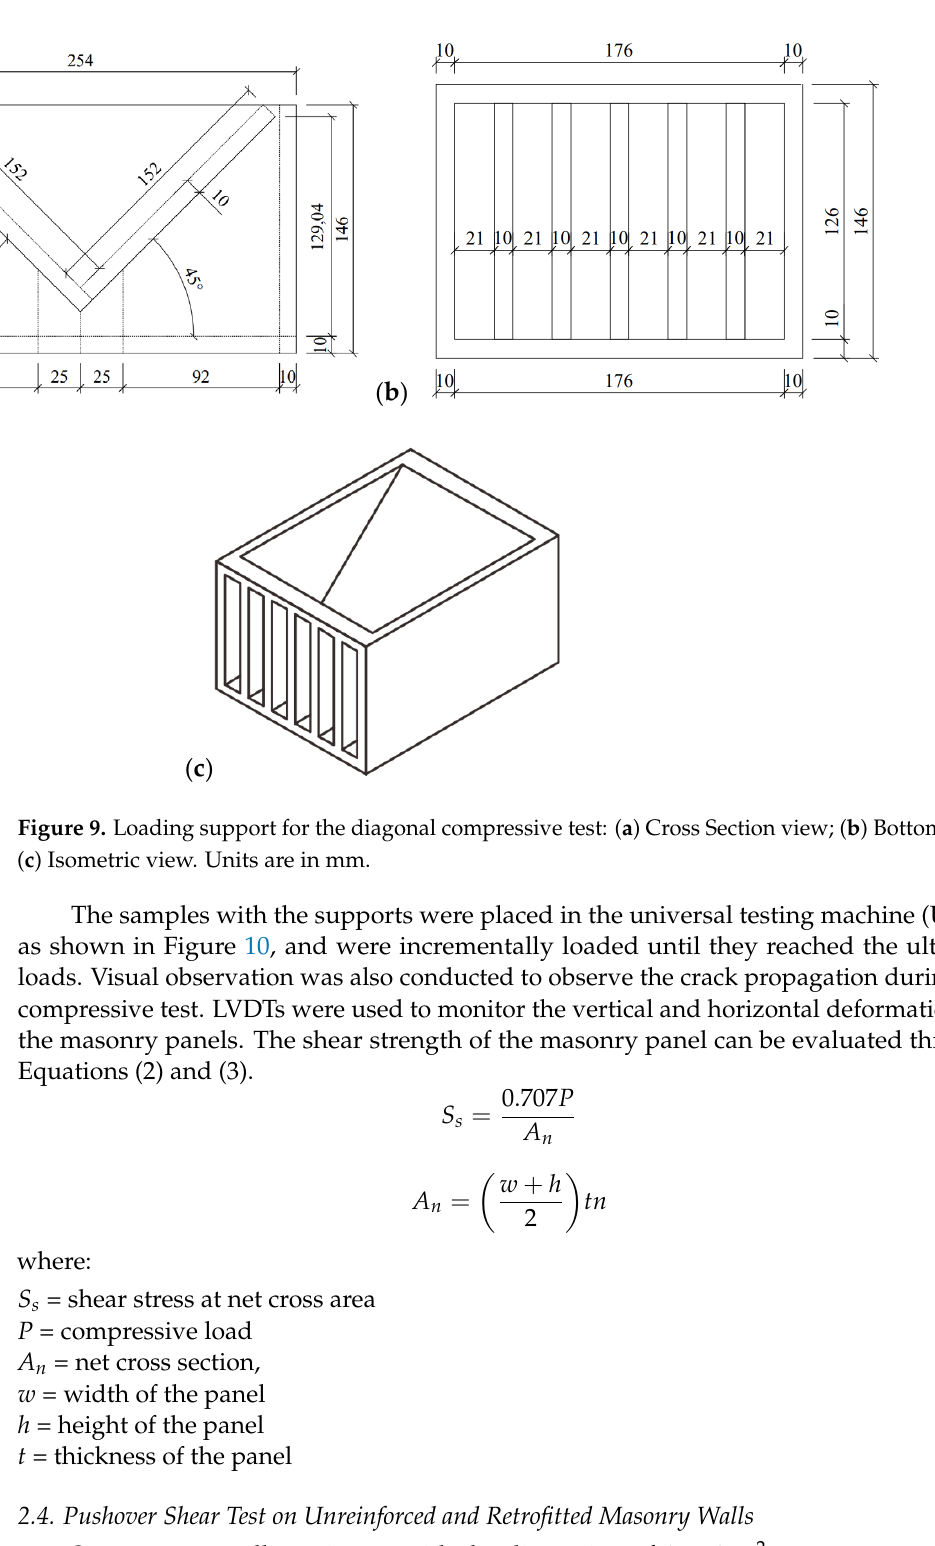
Figure 8. ( a ) The dimension of the masonry panel for the diagonal compressive test, ( b ) the dimen- sion of the brick unit, and ( c ) the thickness of the mortar joint.